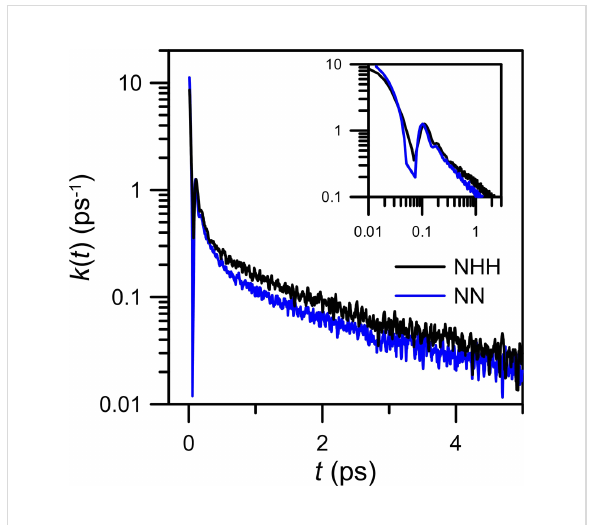
Figure 15: Semi-logarithmic plot of the reactive flux correlation func- tions k ( t ) for hydrogen bridges between water and nitrogen atoms calculated for NHH and NN separation systems. The inset panel shows the log–log plot of the same data.